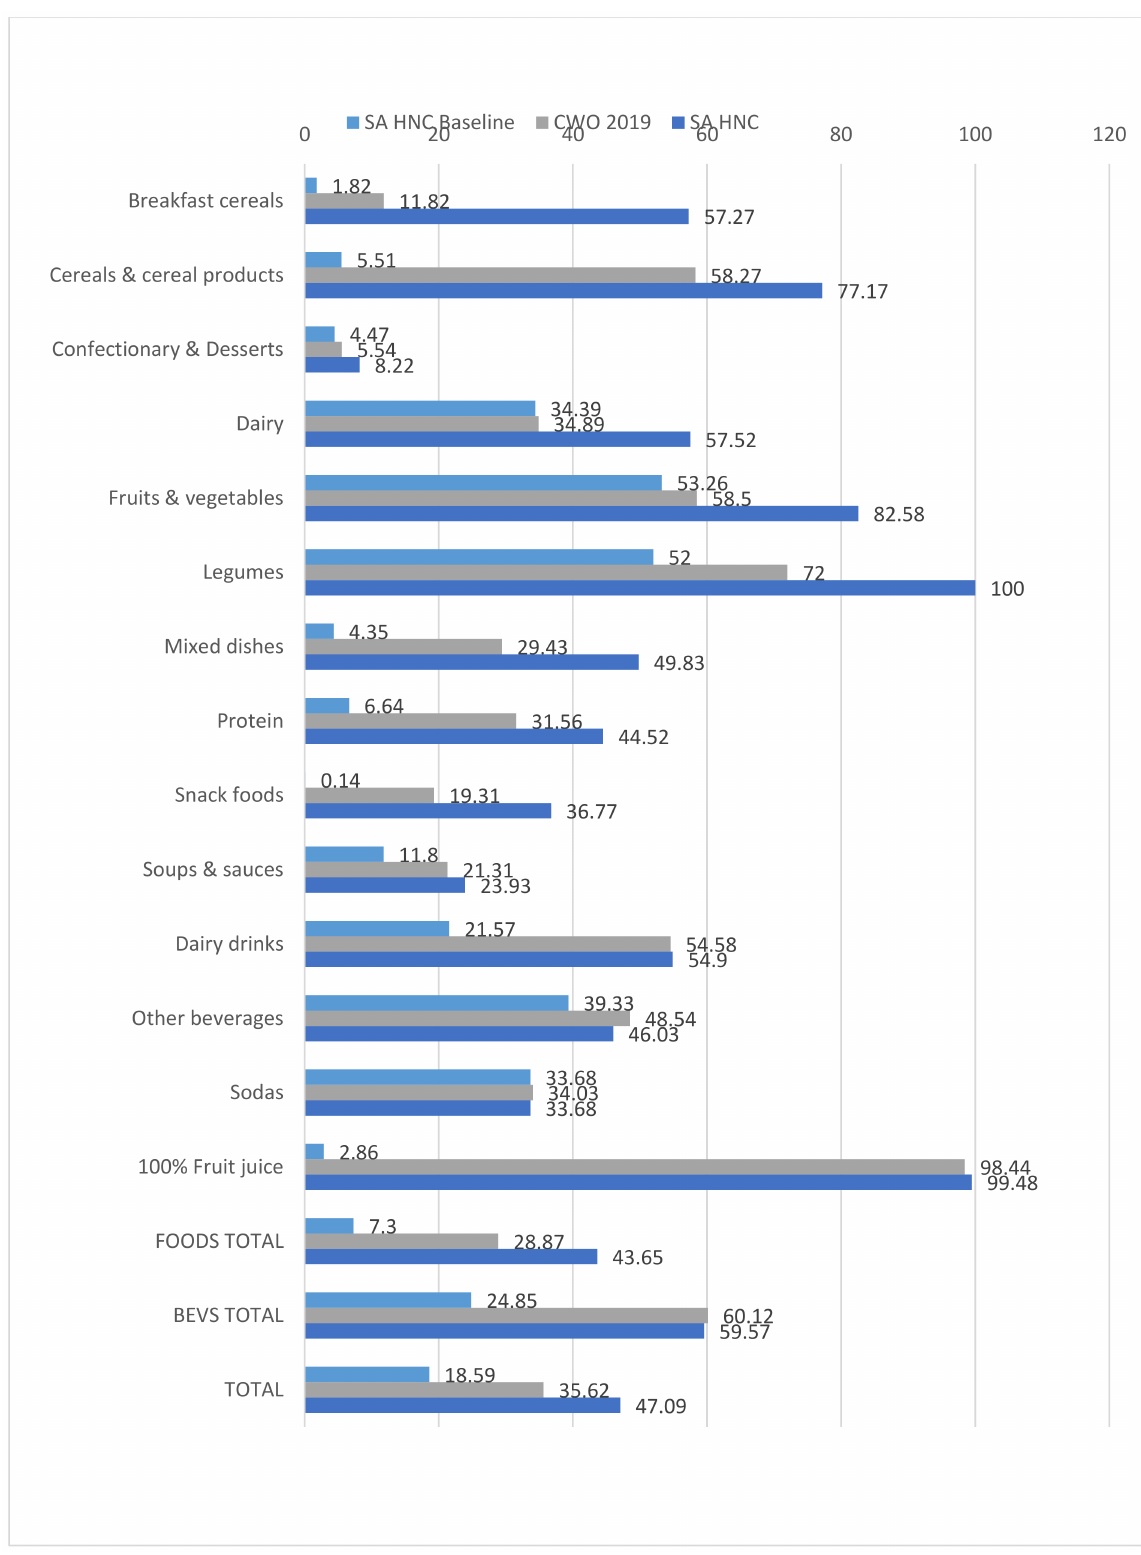
Figure 2. Proportion of SA packaged food and beverage products compliant with the SA HNC, SA HNC baseline and CWO 2019 NPM criteria by